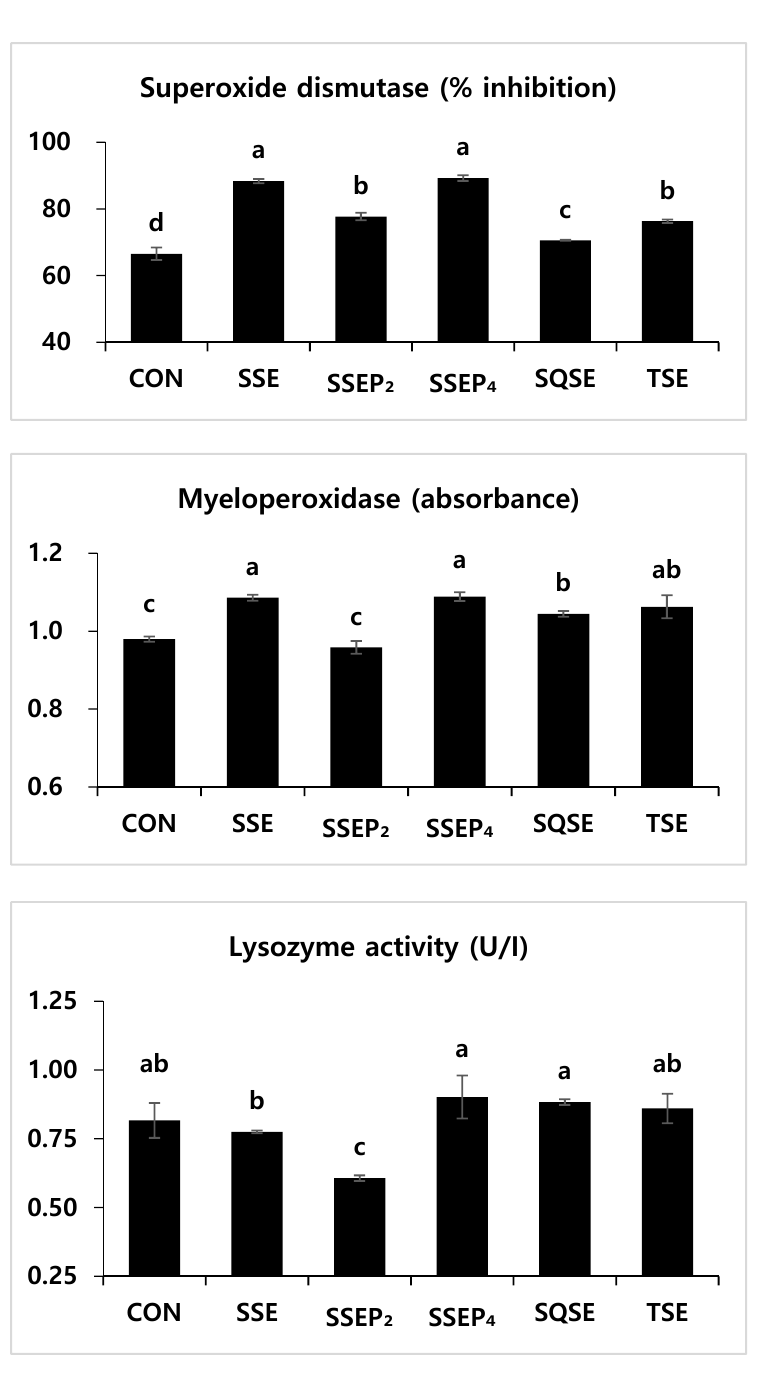
Figure 1. Non-specific immune responses of juvenile Nile tilapia fed six experimental diets in triplicate ( n = 3) for eight weeks. Values represent mean ± SD ( n = 3). Different letters (a,b,c) indicate a significant difference ( p < 0.05).